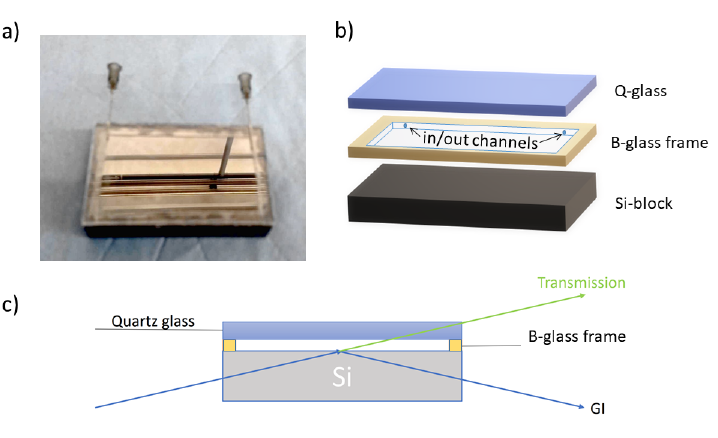
Figure 4. Cell design with minimum amount of auxiliary material. ( a ) shows a photograph of the cell, the assembly is presented in ( b ). The beam path for reflected and transmitted beam is shown in ( c